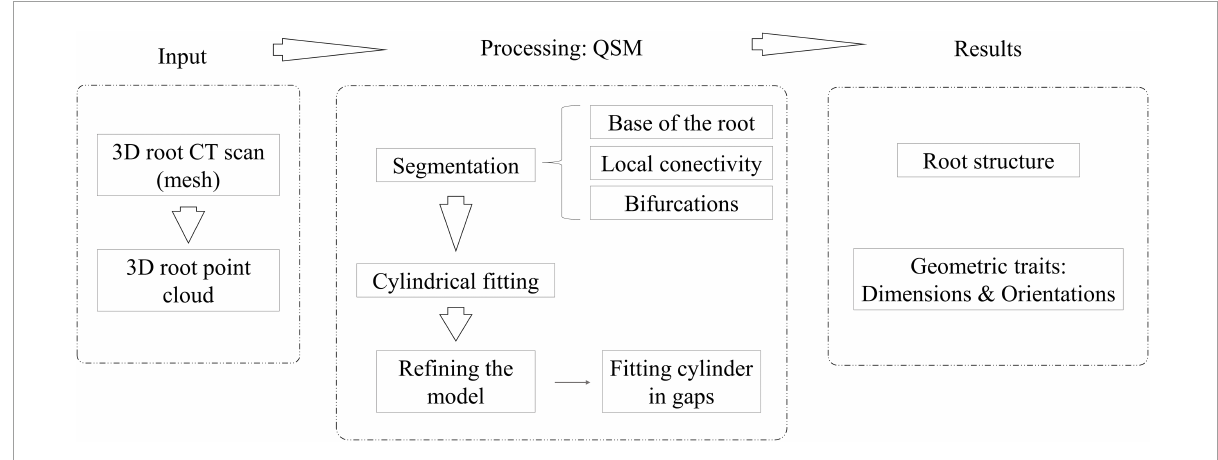
FIGURE1 Workflow of 4DRoot, i.e., required input, the quantitative structure models (QSM) processing, and the computed